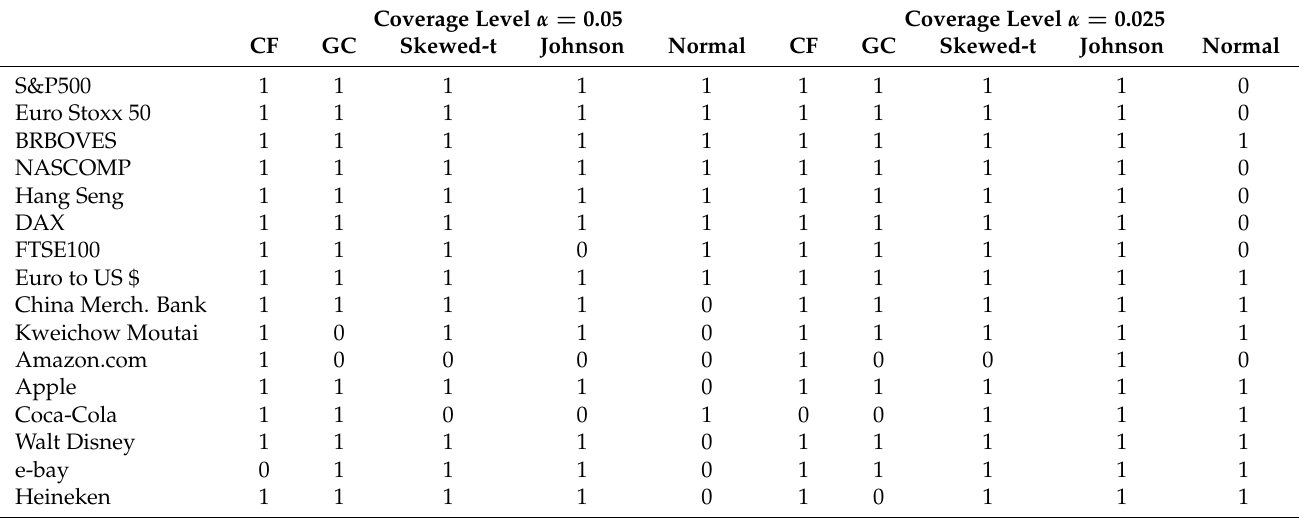
Table 3. Backtesting VaR at the 5% Significance Level.